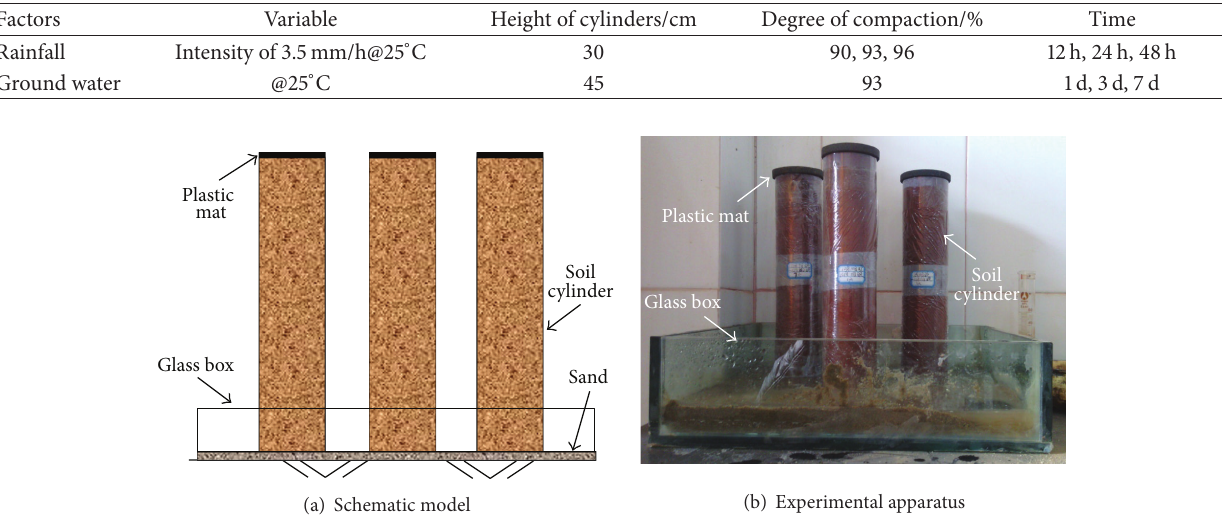
Figure 4: Ground water simulation tests on red clay cylinder specimen.